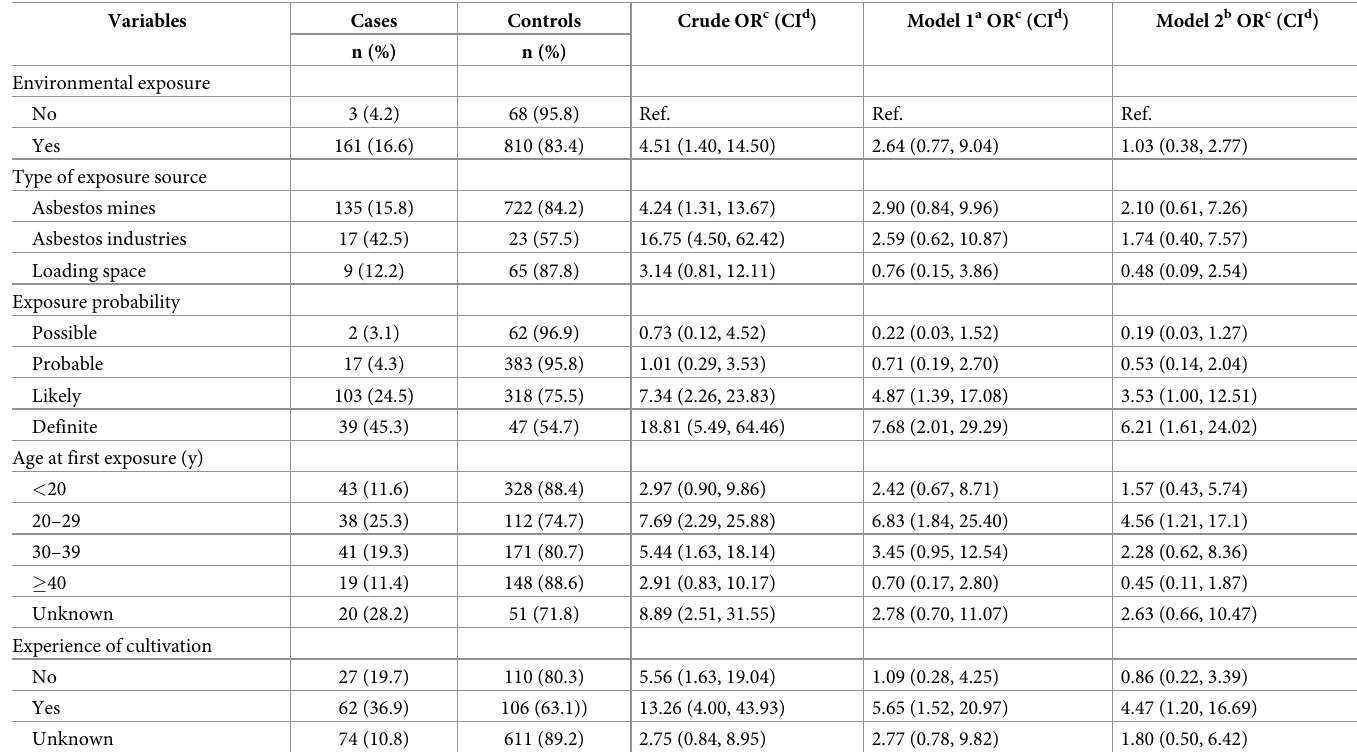
Table 4. Risk of lung cancer according to environmental asbestos exposure.